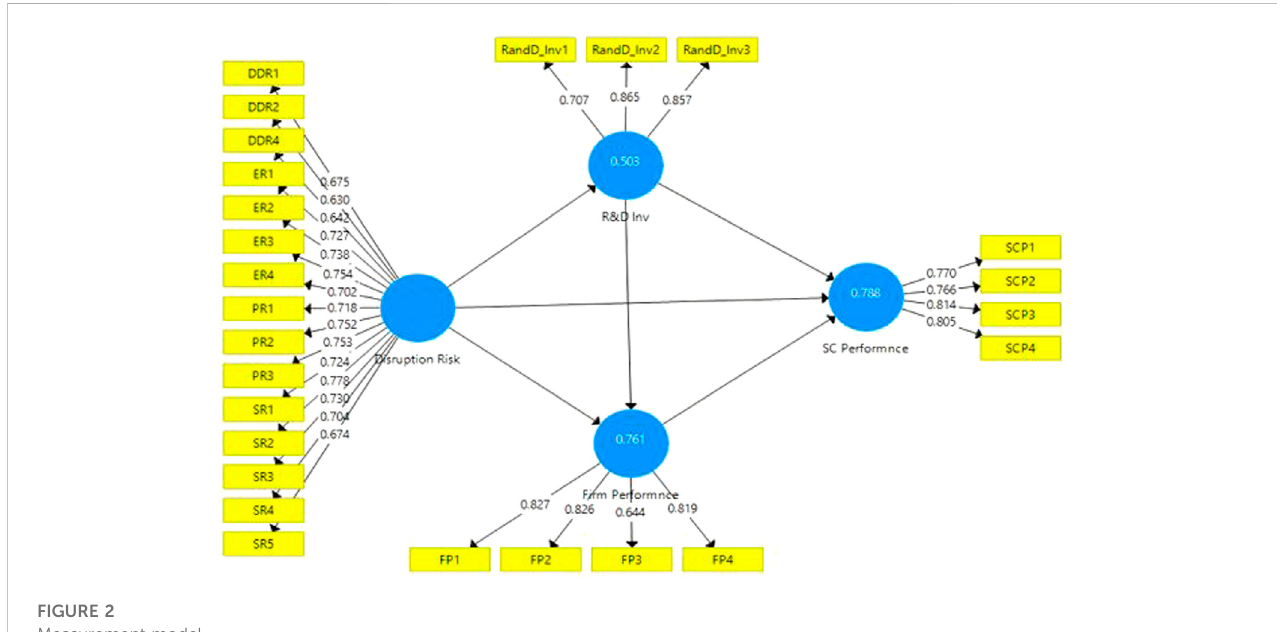
FIGURE 2 Measurement